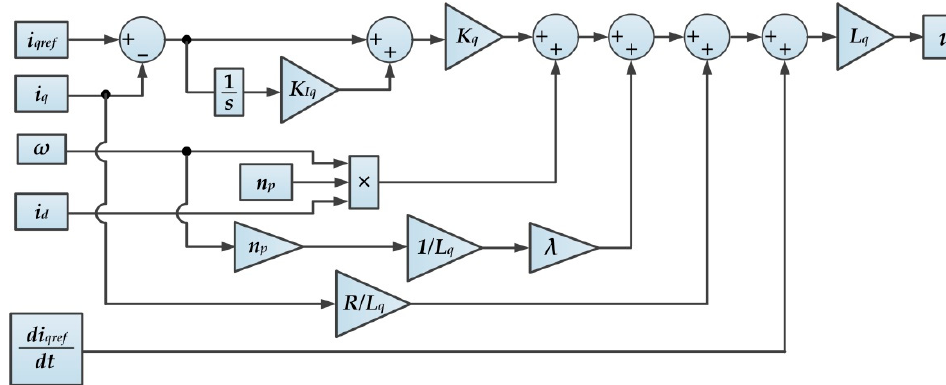
Figure 7. Block diagram of the synthesized control signal u q .